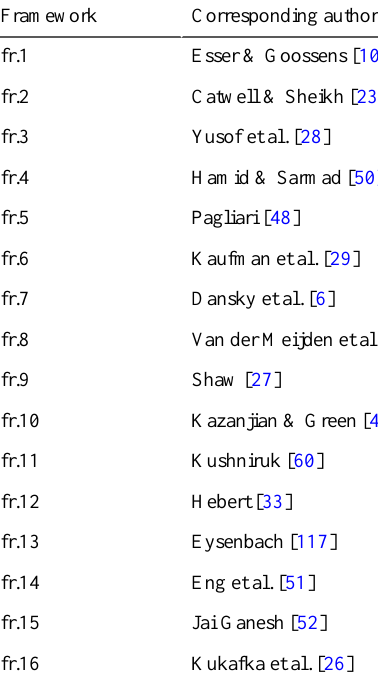
Table 1. eHealth frameworks that matched the inclusion